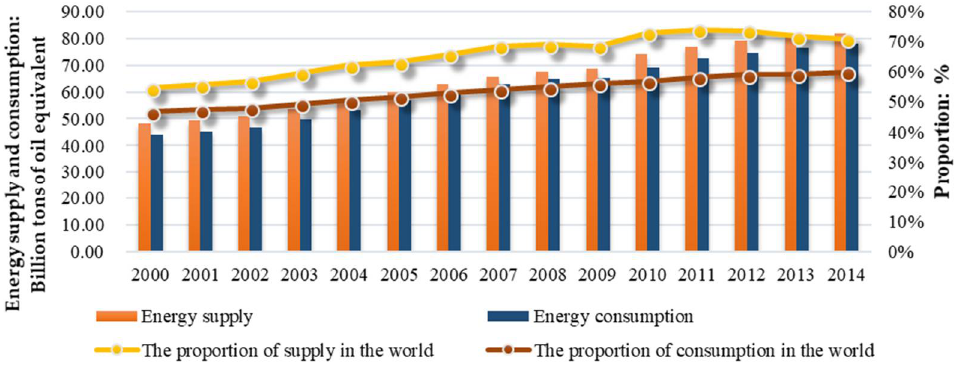
Figure 2. The total energy production and consumption of B&R countries from 2000 to 2014.